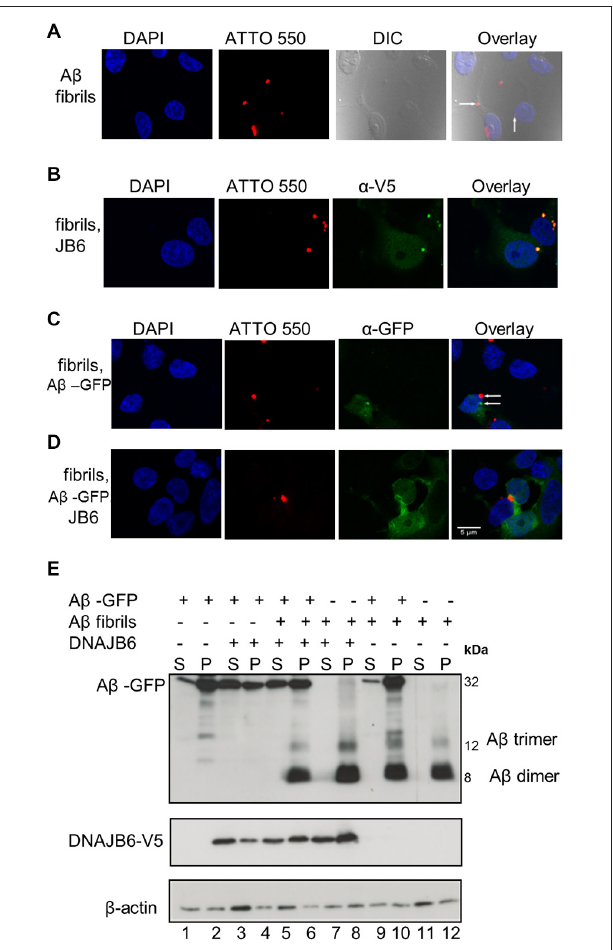
FIGURE 4 | A β 42 -GFP aggregates do not co-localize with extracellular A β 42-ATTO peptides. (A) One micromolar of A β 42-ATTO 550 fibrils were added into the culture medium of HEK293 cells for 24 h Cells were fixed and stained with DAPI for nuclear staining. Confocal images were acquired by Leica SP8 confocal microscope. Extracellular A β peptides can enter the cells and form intracelluar aggreagtes. (B) HEK293 cells were transfected with DNAJB6-V5 in 1:3 ratio. After 24 h transfection, 1 µ M of A β 42 fibrils were added into the culture medium of cells for another 24 h and cells were fixed and stained with anti V5. Confocal images show that DNAJB6 cannot prevent the extracellular A β mediated aggregation. (C) Cells were transfected with 1 µ g Ub-A β -GFP. After 24 h transfection, 1 µ M of A β 42 fibrils were added into the culture medium of cells for another 24 h Cells were fixed. Confocal images show that extracellular A β peptides do not co-localize with A β -GFP. (D) Cells were transfected with Ub-A β -GFP and DNAJB6 in 1:3 ratio for 24 h then 1 µ M of A β 42-ATTO 550 fibrils were added into the culture medium of HEK293 cells for another 24 h Cells were fixed and immunostained as mentioned above except that DNAJB6 is not stained for. Images show that DNAJB6 can still decrease the aggregation of intracellular A β 42-GFP in presence of extracellular A β peptides. ATTO 550 was used to detect extracellular A β peptides, GFP for A β 42-GFP, anti V5 for DNAJB6 and DAPI for nuclei. DIC: differential interference contrast. Scale bar = 5 µ m. (E) Western blot of cells transfected and fractionated as mentioned